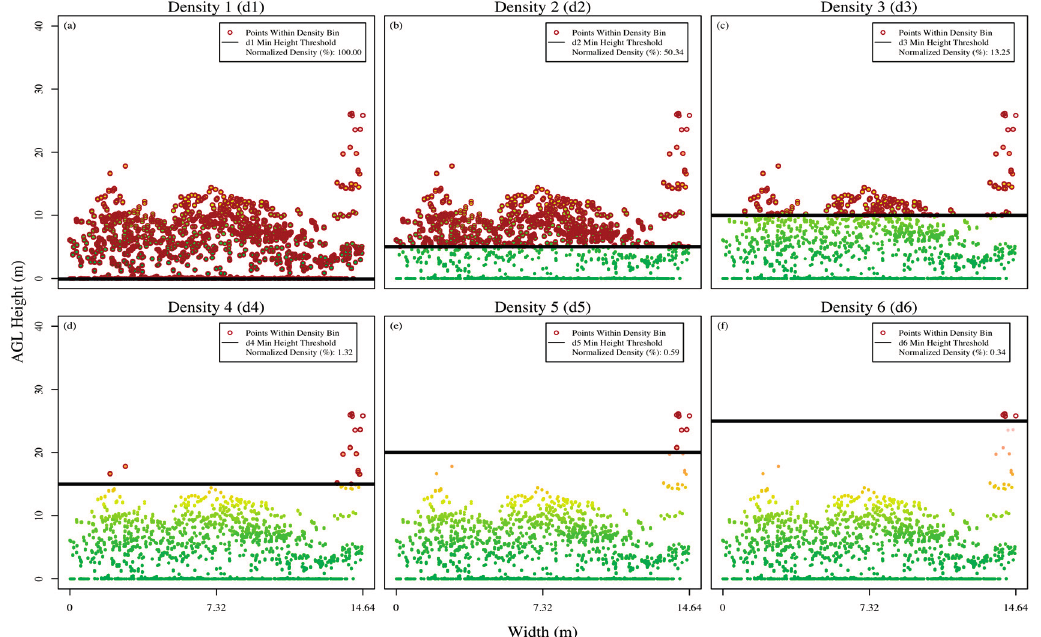
Figure 5. Cross sectional plot of one subplot point cloud visualizing the minimum height thresholds for density metrics, with subfigures a through f highlighting all points above the minimum height thresholds of 0 m ( a ), 5 m ( b ), 10 m ( c ), 15 m ( d ), 20 m ( e ), and 25 m ( f ),